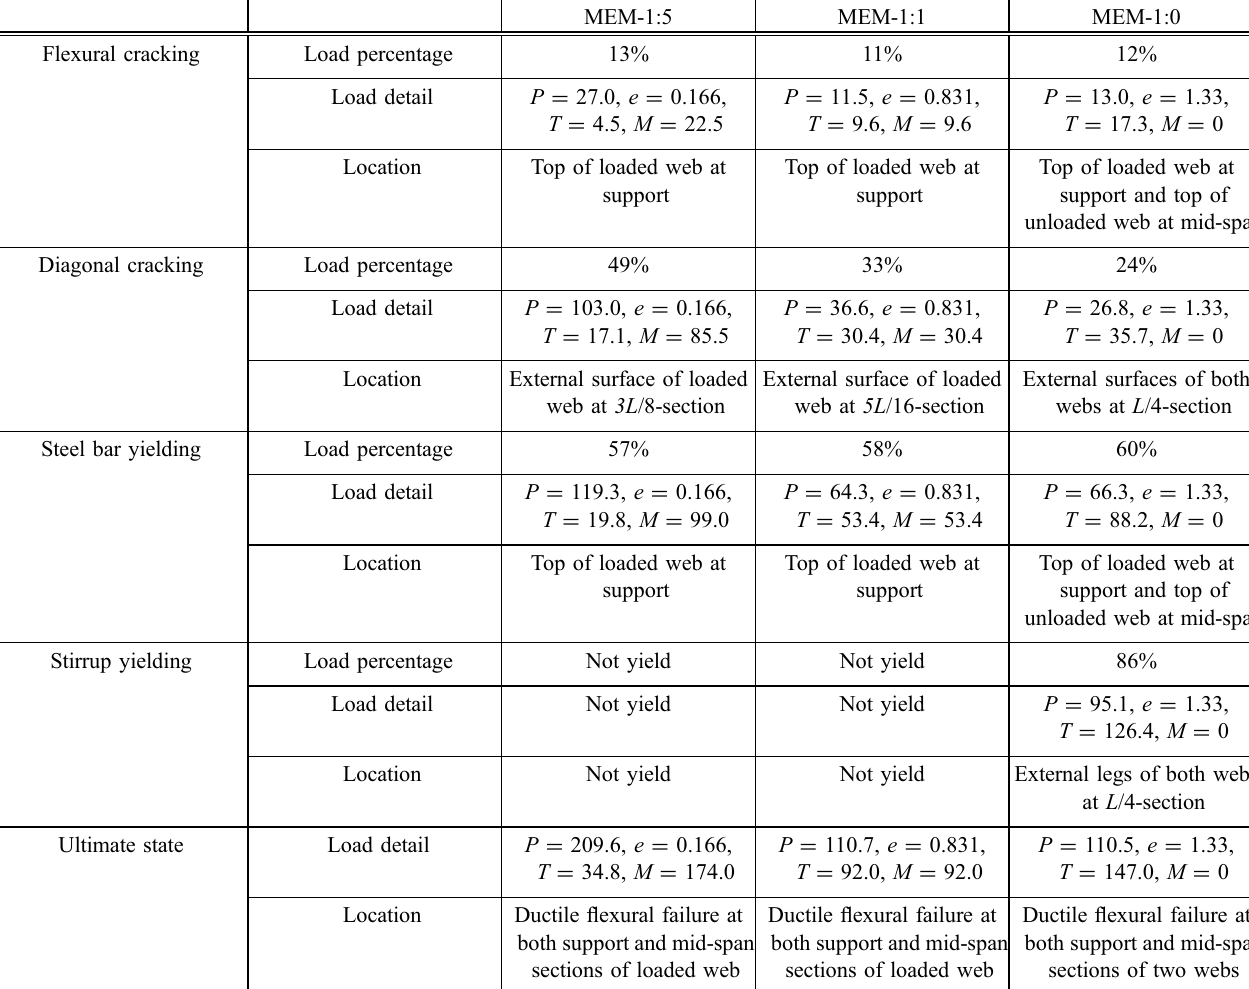
Table 2 Characteristic loads and their locations of beam